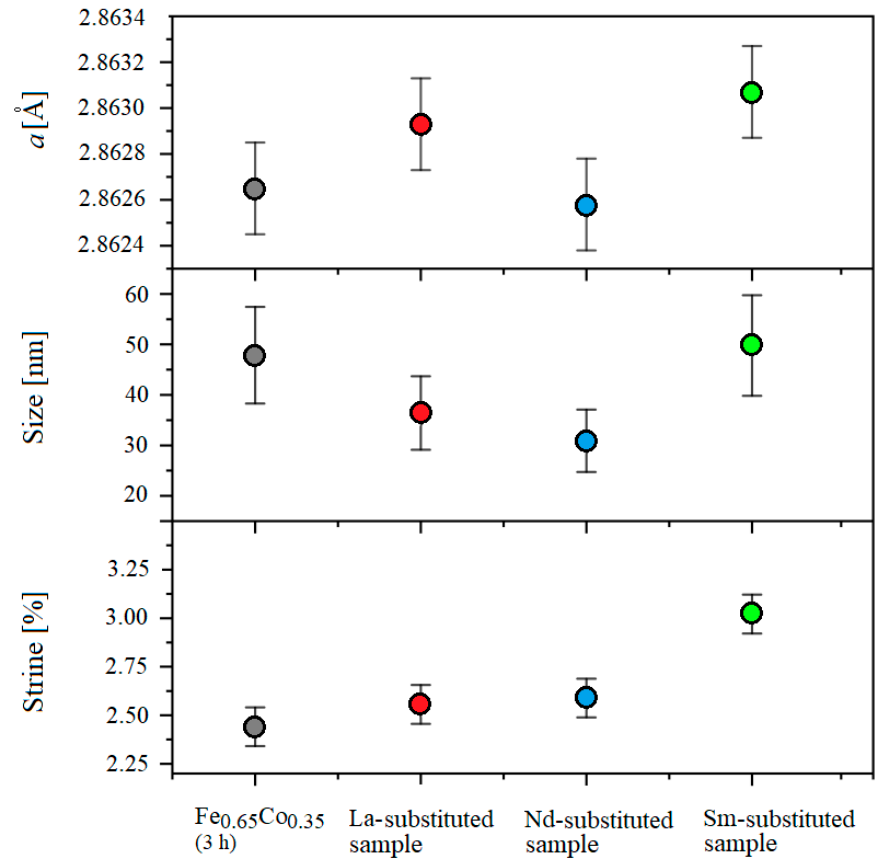
Figure 5. The crystallite size, microstrain and lattice parameter refined by the Rietveld analysis for pure Fe 0.65 Co 0.35 alloy and for (Fe 0.65 Co 0.35 ) 0.95 ( RE 2 O 3 ) 0.05 samples with RE = La, Nd, and Sm.